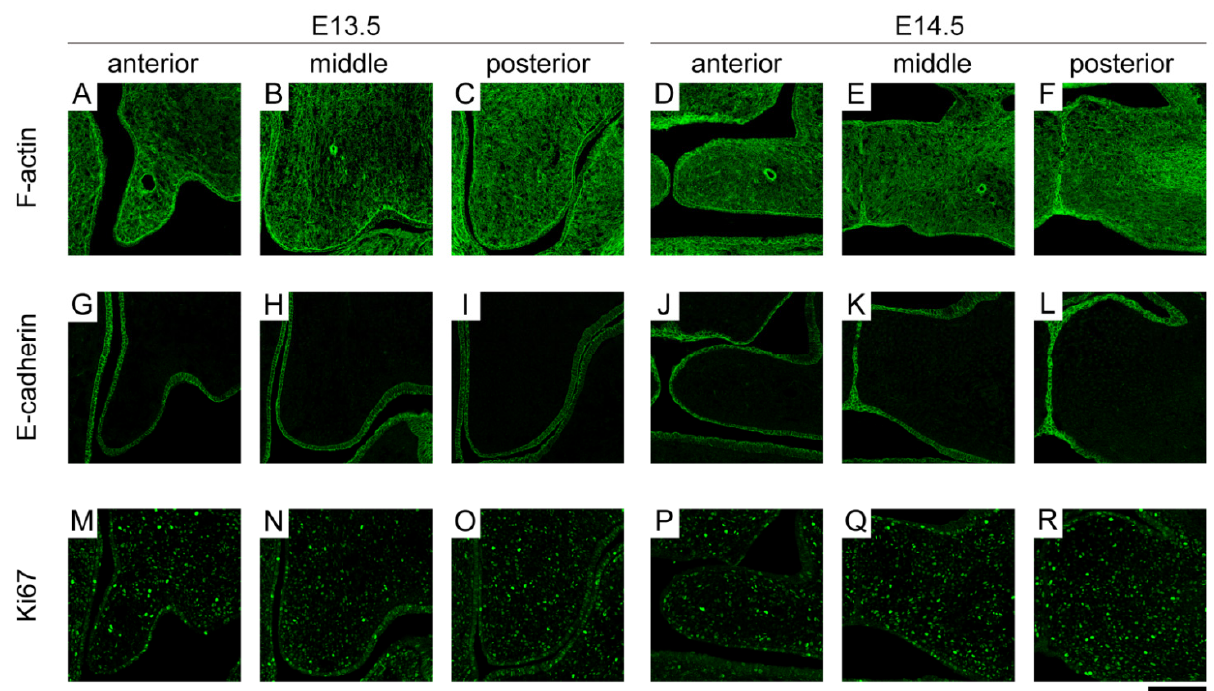
Figure 2. The immunohistochemical patterns of Pax9, Osr2, and Tgf β 3 expression during palate development. Confocal micrographs of immunostaining for ( A – F ) Pax9, ( G – L ) Osr2, and ( M – R ) Tgf β 3 obtained at both E13.5 and E14.5 palatal shelves in anterior-to-posterior parts. Scale bar: 50 µ m.